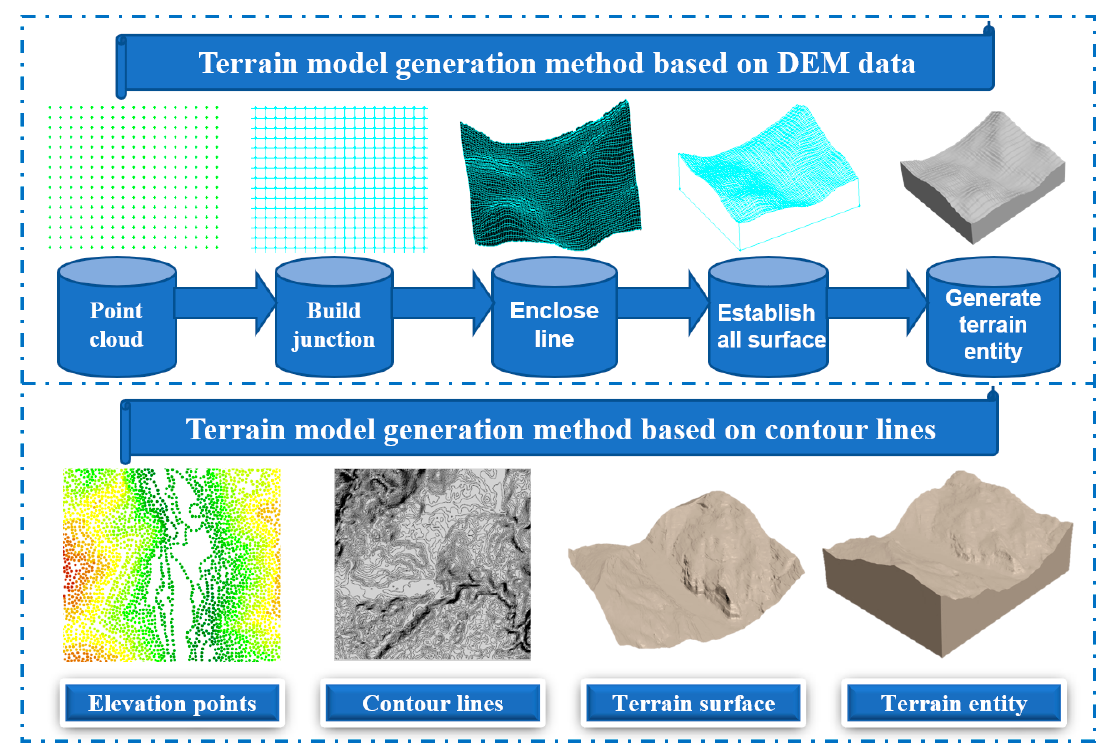
Figure 3. Terrain generation based on DEM and contour lines.